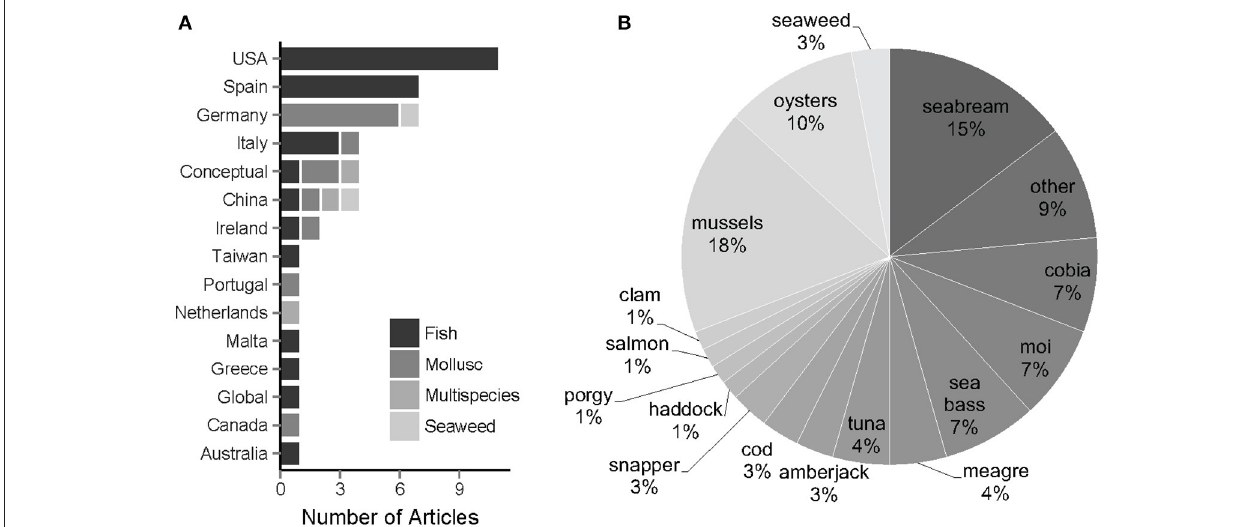
FIGURE 2 | (A) Number of biologically relevant articles and the associated countries and taxonomic groups referenced in gray and primary literature. Conceptual refers to articles that had no particular country of focus, but rather reviewed and/or discussed offshore aquaculture in a conceptual context. In the legend, multispecies (medium gray) represents studies that incorporate a combination of two or more of the taxonomic groups. (B) Percent of offshore aquaculture articles that focus on the species or group of species listed.